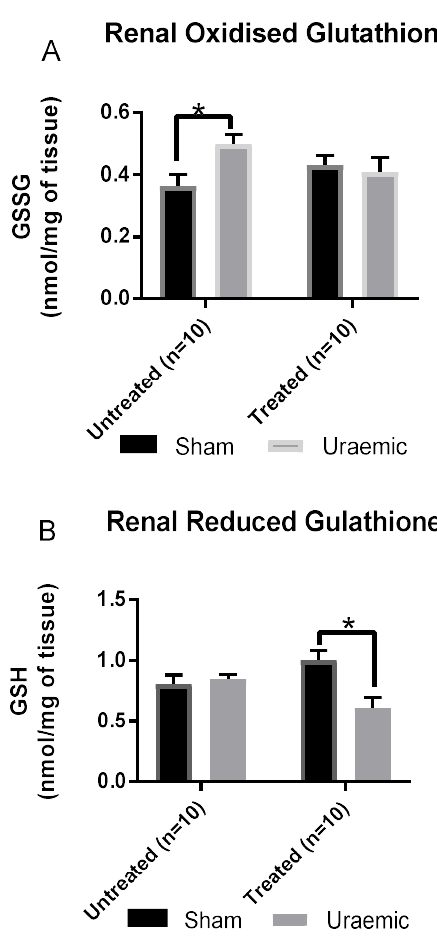
Figure 6. Serum TBARS. TBARS (thiobarbuturic acid reactive substances) were measured to access lipid peroxidation in uraemic and sham animals. Results are presented as mean ± SEM. (* p < 0.01).